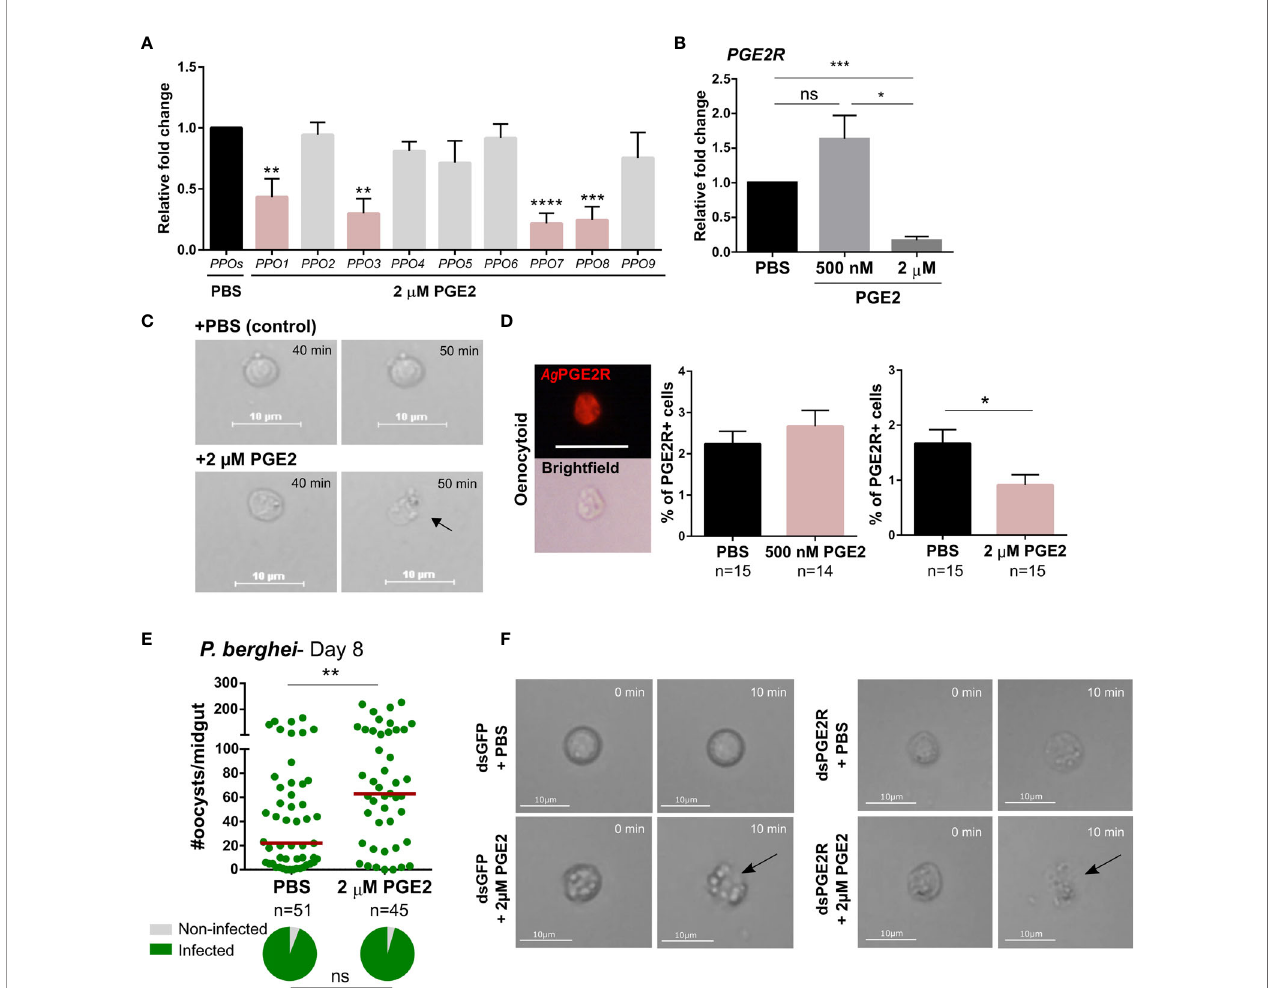
FIGURE 5 | High concentration of PGE2 triggers oenocytoid lysis. (A) The in fl uence of high PGE2 concentrations (2 µM) was examined on prophenoloxidase (PPO) gene expression, where the subset of PPO genes regulated by PGE2 treatment ( PPO1, 3, 7 and 8 ) are signi fi cantly reduced. (B) Similarly, AgPGE2R expression was also reduced when mosquitoes were primed with 2 µM PGE2, yet was unaffected by 500 nM PGE2. and PBS control. (C) To determine whether high concentration of PGE2 triggers oenocytoid cell lysis, video recordings were performed for one hour, focusing on oenocytoids after exposure to 1xPBS or 2 µM PGE2. Still images of oenocytoids were captured at 40 min and 50 min of the incubation. Oenocytoid cell lysis (black arrow) was observed around 50 min incubation of 2 µM PGE2. To verify if oenocytoid immune cell populations were in fl uenced by PGE2 levels, immuno fl uorescence assays (IFAs) were performed to label mosquito oenocytoids (D) . There was no difference in the proportion of Ag PGE2R+ oenocytoid cells between PBS and 500 nM PGE2 treatments, yet 2 µM PGE2 treatments reduced oenocytoid populations supporting that high levels of PGE2 promote oenocytoid lysis. The scale bar represents 10 µm. (E) When oenocytoid lysis was triggered by 2 µM PGE2 treatment prior to P. berghei infection, Plasmodium survival was signi fi cantly increased when oocyst numbers were examined 8 days post-infection. Similar to (C) , video recordings were performed focusing on oenocytoids after exposure to 1xPBS or 2 µM PGE2 in either GFP- or PGE2R-silenced mosquitoes (F) . Still images of oenocytoids were captured at 0 min and 10 min following incubation. Oenocytoid cell lysis (black arrow) was observed around 10 min incubation of 2 µM PGE2. Data presented in (A, B, D) were analyzed using an unpaired t-test to determine differences in relative gene expression or oenocytoid abundance using GraphPad Prism 7.0. Bars represent mean ± SE of three independent biological replicates for (A, B) , and two independent biological replicates for (D) Oocyst data from three independent experiments were analyzed by Mann – Whitney. Median oocyst numbers are indicated by the horizontal red line. The prevalence of infection (% infected/total) is depicted for mosquitoes under each experimental condition and examined by X 2 analysis to determine signi fi cance. Asterisks denote signi fi cance (* P < 0.05, ** P < 0.01, *** P < 0.001, **** P < 0.0001); ns, not signi fi cant. n = number of individual mosquitoes examined. Genes that display signi fi cant differences in gene expression following PGE2 treatment are shaded in